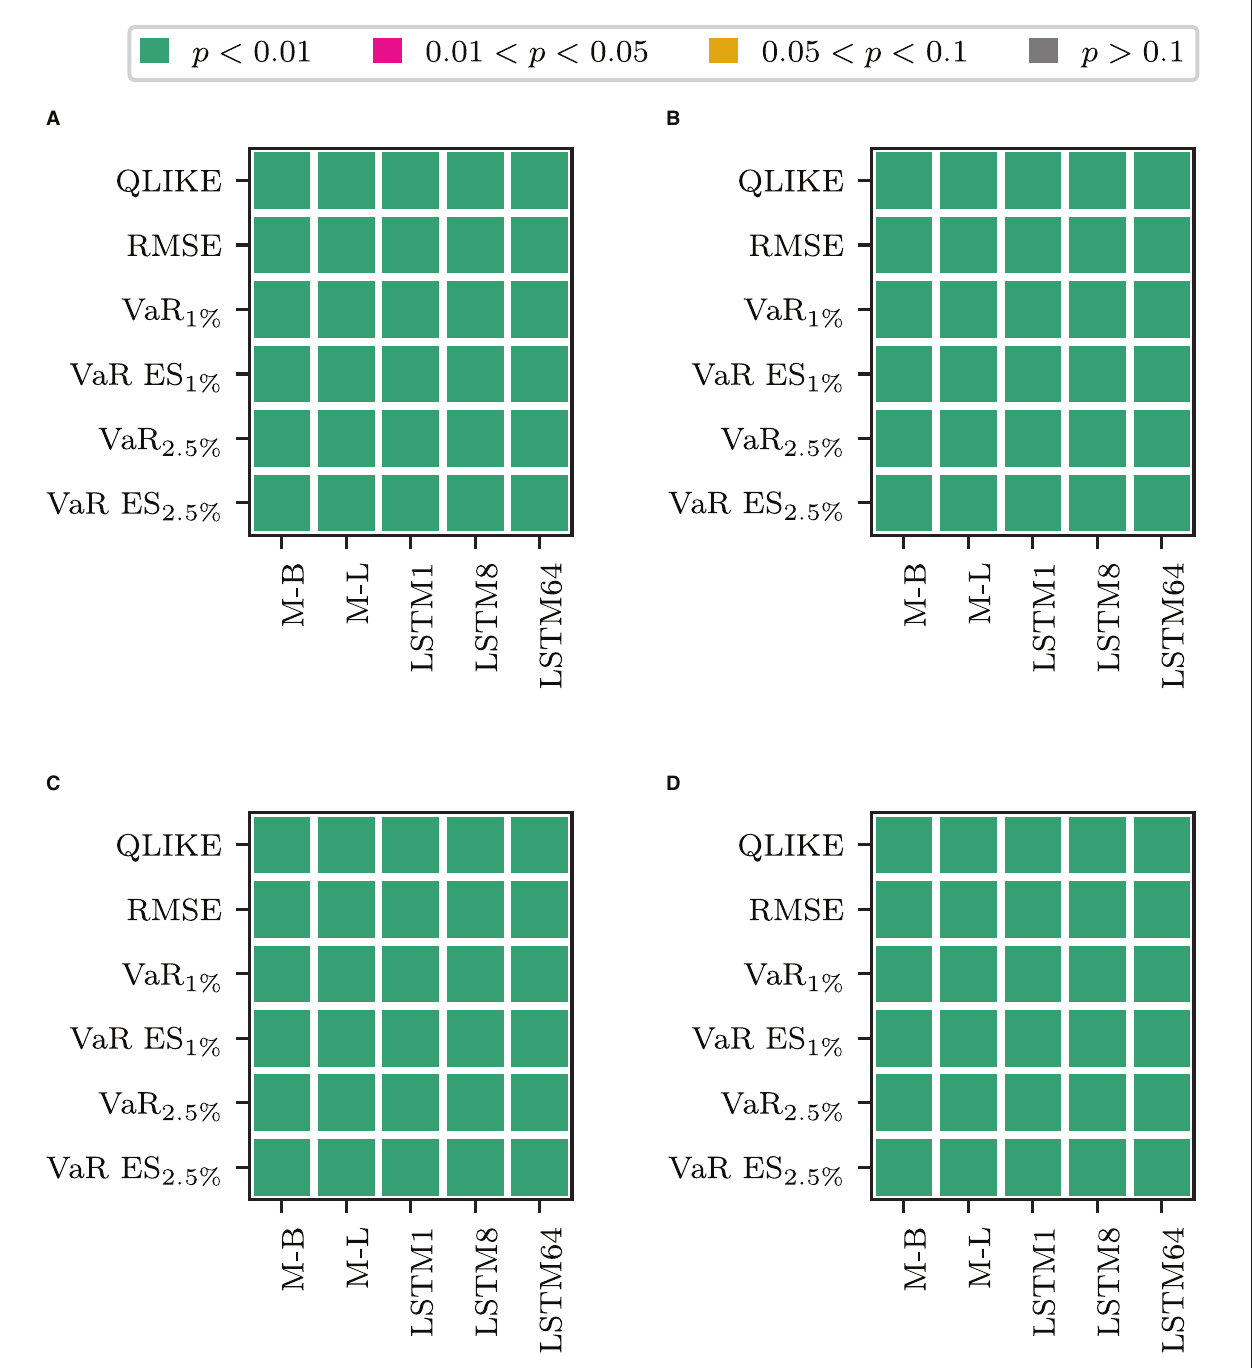
them, the model that uses the non-linear transformation via one LSTM cell performs best. The differences in the forecasting performance of the only transformed measure models to